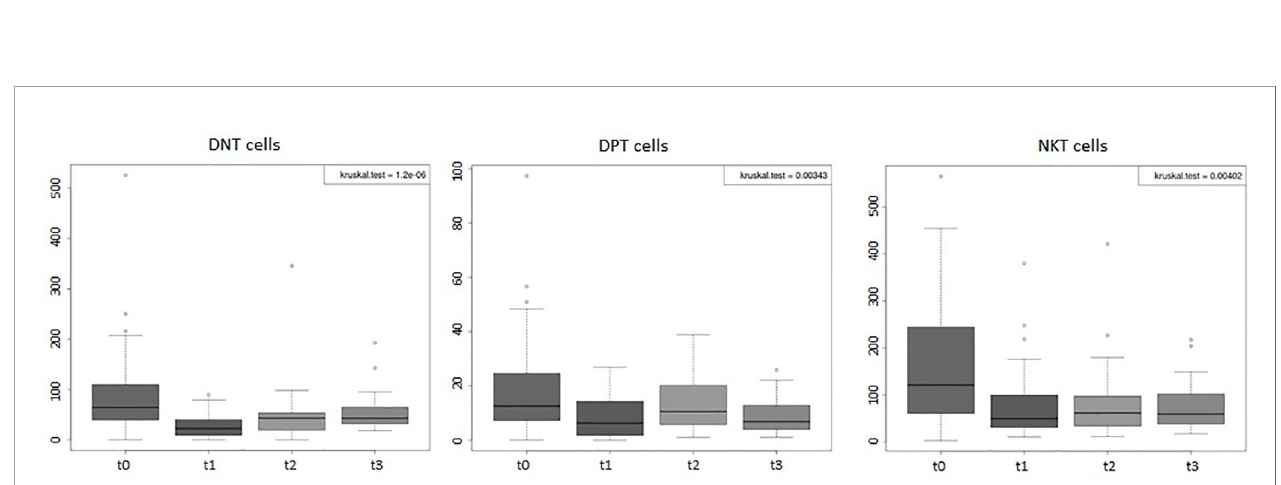
FIGURE 4 | Boxplots of the absolute values of double-negative T (DNT), double-positive T (DPT), and NKT cells of the entire group of prostate cancer patients (44) undergoing curative RT. The data shown evidenced variations statistically signi fi cant during the four time points considered (Kruskal – Wallis test, p -value < 0.005). t0: before RT; t1: end of RT; t2: 3 months after RT; t3: 6 months after RT. All values are expressed as cells/µl.